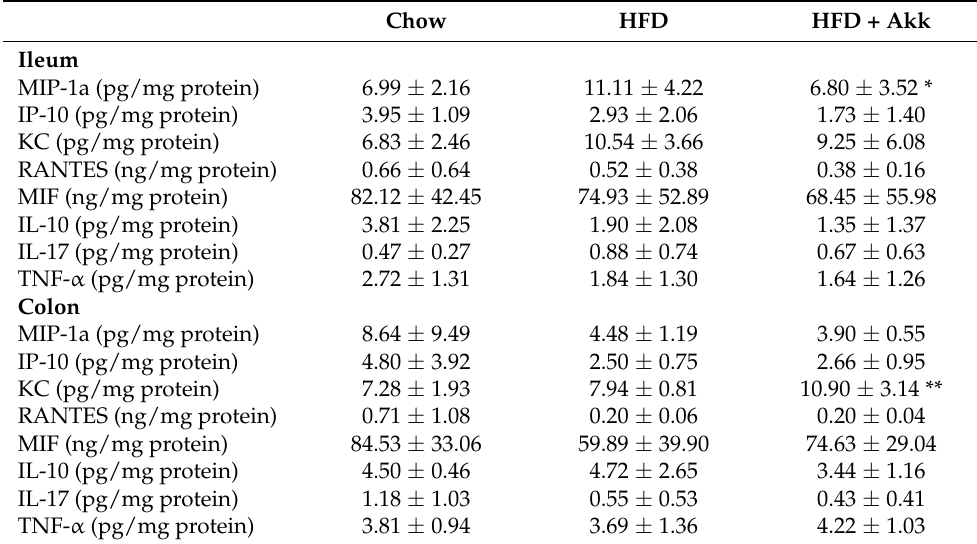
Table 2. Protein levels of chemokines and cytokines in ileum and colon